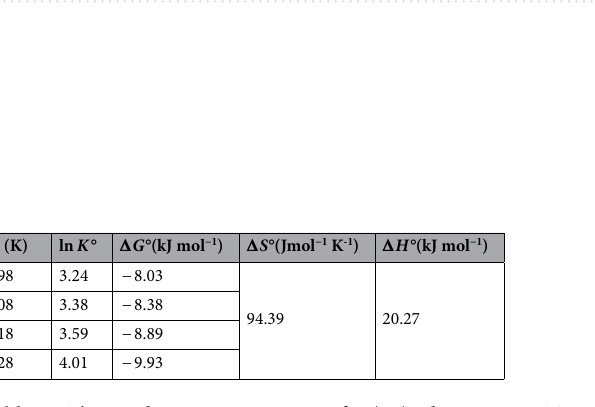
Table 5. Thermodynamic parameters of Pt(IV) adsorption on